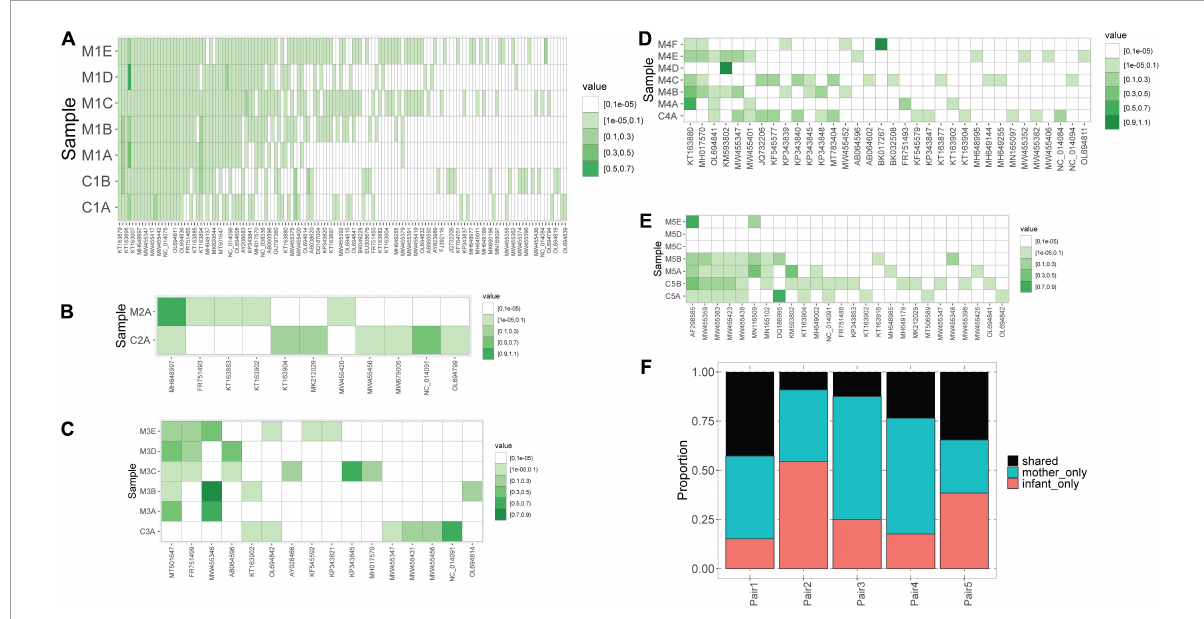
FIGURE2 Blood anellomes of mothers and children. Heatmaps of relative abundance of different anellovirus lineages ( x -axis) in samples ( y -axis) within pair #1 (A) , pair #2 (B) , pair #3 (C) , pair #4 (D) and pair #5 (E) . The stronger the color, the higher the relative abundance (indicated by “value”), and the white color indicates the absence of a lineage. (F) Proportion of shared and not shared lineages within each pair. The unshared lineages were either detected solely in the mother (“mother-only”) or in the child